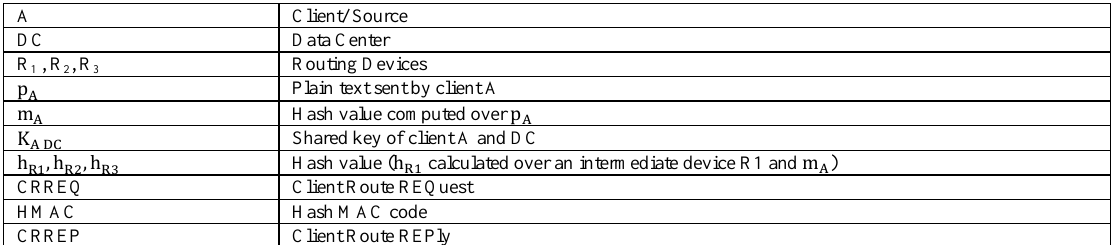
Table 2. Table of